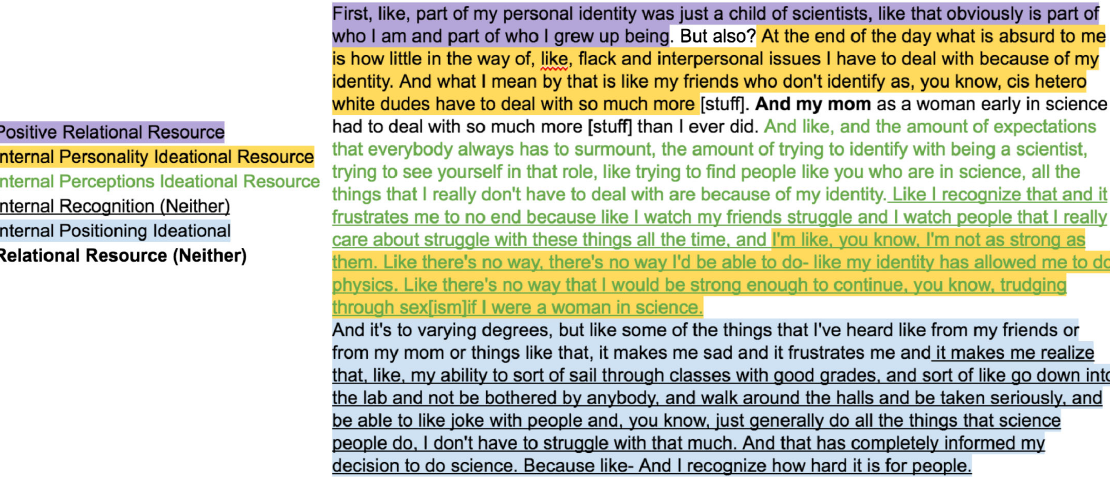
FIG. 3. An excerpt from Jeff ’ s coded interview using the Critical Physics Identity